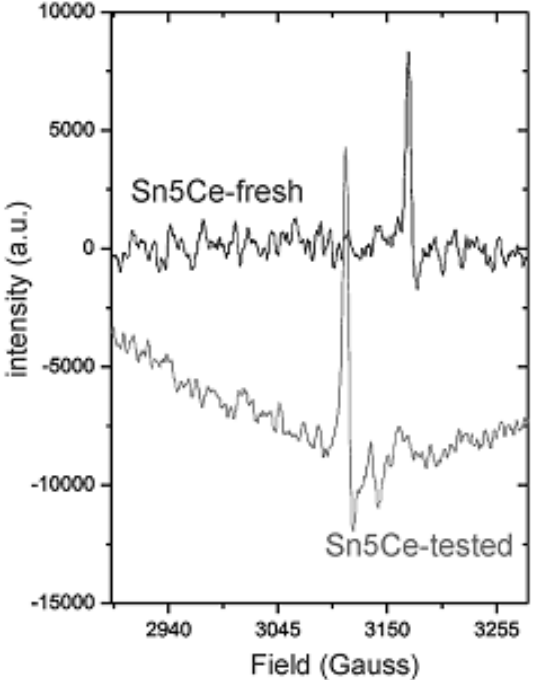
Chemosensors 2023 , 11 , x FOR PEER REVIEW 14 of 43 Figure 9. SnO 2 -CeO 2 sensor series sensitivity to CO at corresponding T w = 400–450 °C, from ref. [40].